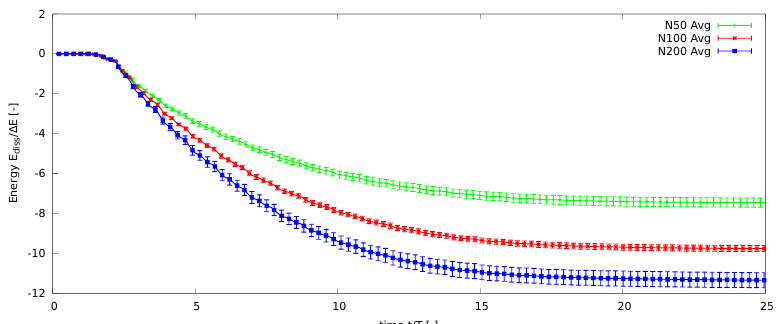
Figure 20. Average oil dissipation for 2D runs with standard deviation for the 10 runs at various resolutions.